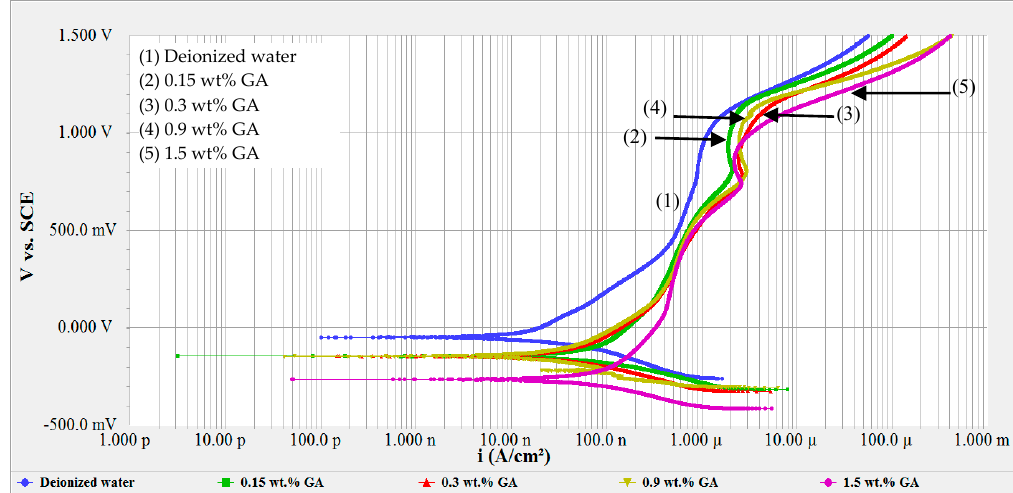
Figure 2. Potentiodynamic scans for 316L stainless steel exposed to GA-water solutions of 0.15, 0.3, 0.9 and 1.5 wt% gum arabic (GA).